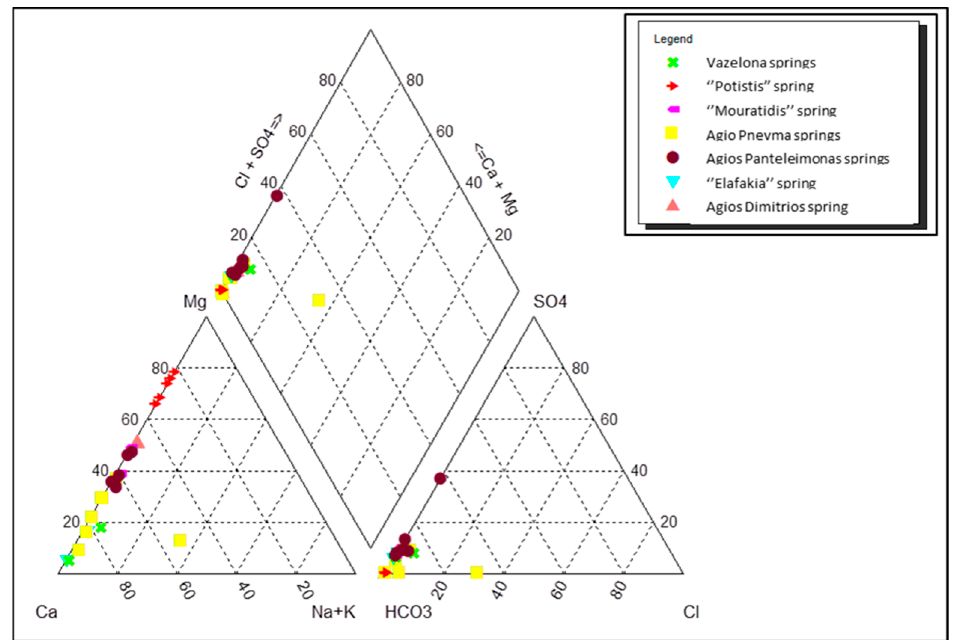
Figure 12. Piper diagram of major ion chemistry for the natural spring